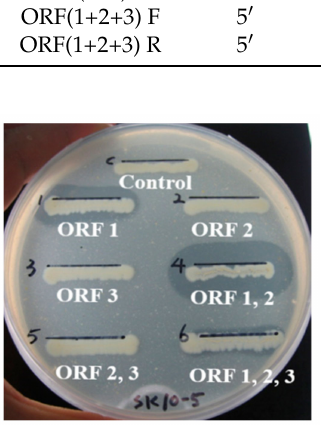
Figure 6. Chitinase activities of subclones of three ORFs in clone SK10-5 on an LBCC plate. ORF1, ORF2, and ORF3 encoded Chi18A, Pro2K, and Chi19B,